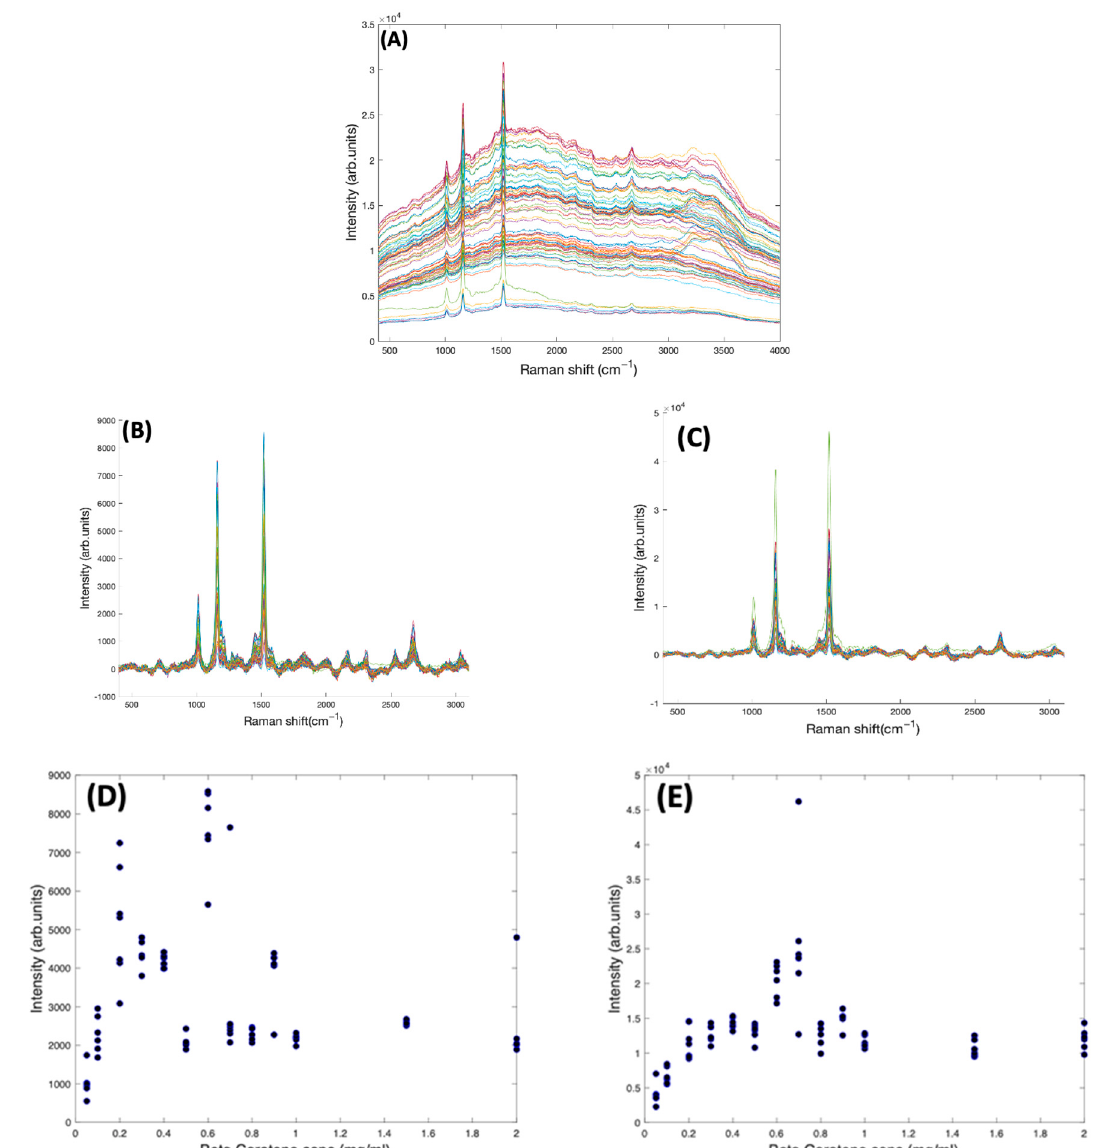
Figure 4. ( A ): Spectra of varying concentrations of Beta Carotene solution (0.05–2.0 mg/mL) showing fairly tightly grouped spectra before background subtraction. ( B ): Spectra of varying concentrations of Beta Carotene after background subtraction and without water normalisation. ( C ): Spectra of varying concentrations of Beta Carotene after background subtraction and with water normalisation. ( D ): concentration dependence of the 1519 cm − 1 Raman peak of Beta Carotene before water normali- sation. ( E ): Concentration dependence of the 1519 cm − 1 Raman peak of Beta Carotene after water